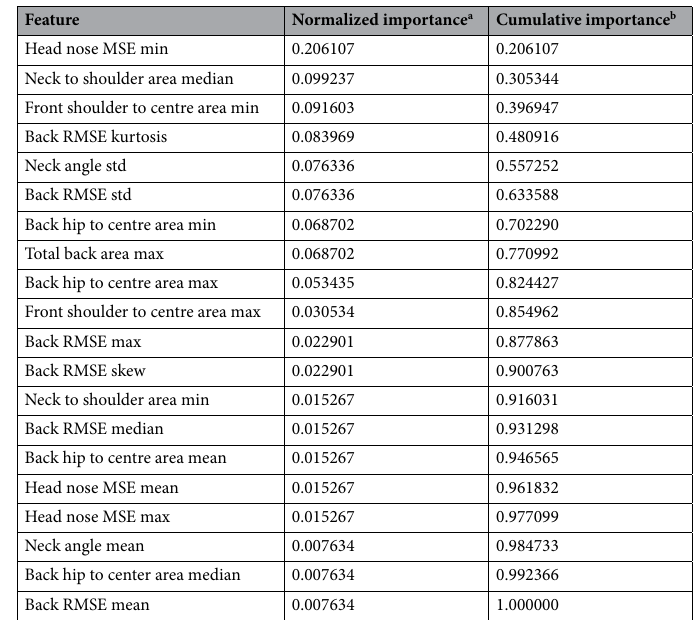
Table 7. Normalized and cumulative importance for each of the features where the normalized importance is greater than zero. a,b The importance values were calculated using boosting ensemble tree-based machine learning as a factor of how much they contributed to the correct binary classification where the labels were ‘Sound’ with an assigned mobility score of 0 and ‘Lame’ with assigned mobility scores of 1–3.